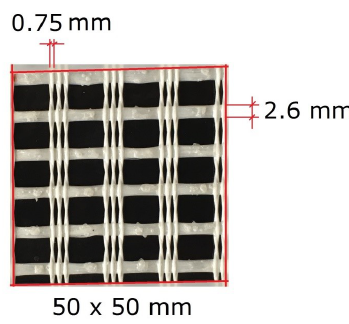
Figure 14: The total area of the gaps is equal to 1430 mm 2 (for 320 g/m 2 the fibreglass